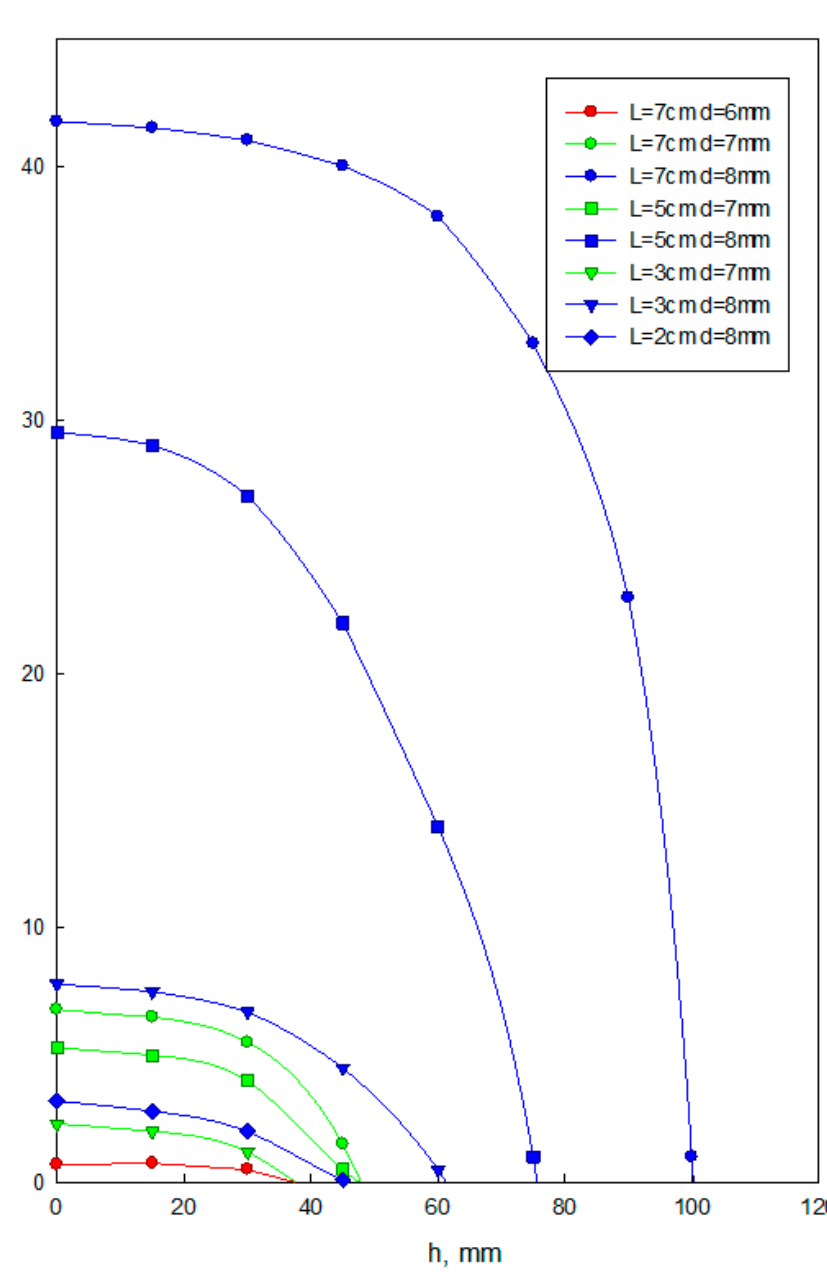
Figure 12. Dependence of the critical delay time on the size of the firebrands and the distance between them.